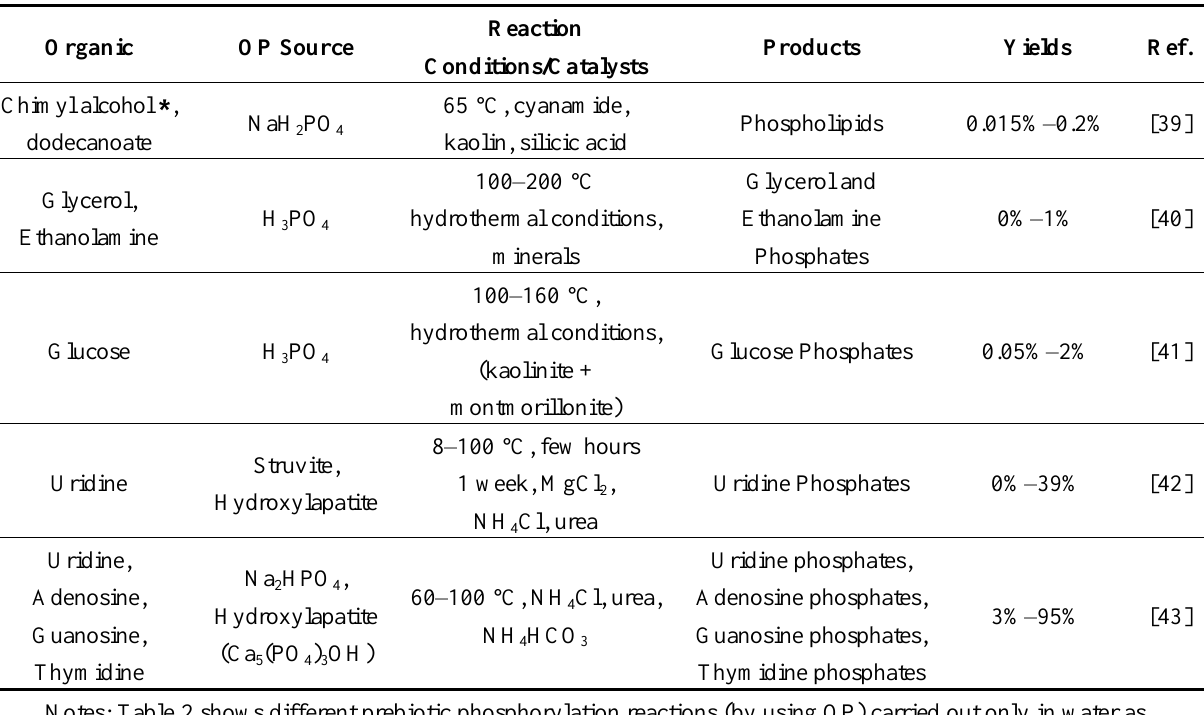
Table 2. Minerals/clays/salts catalyzed phosphorylation reactions by using OP as a source of